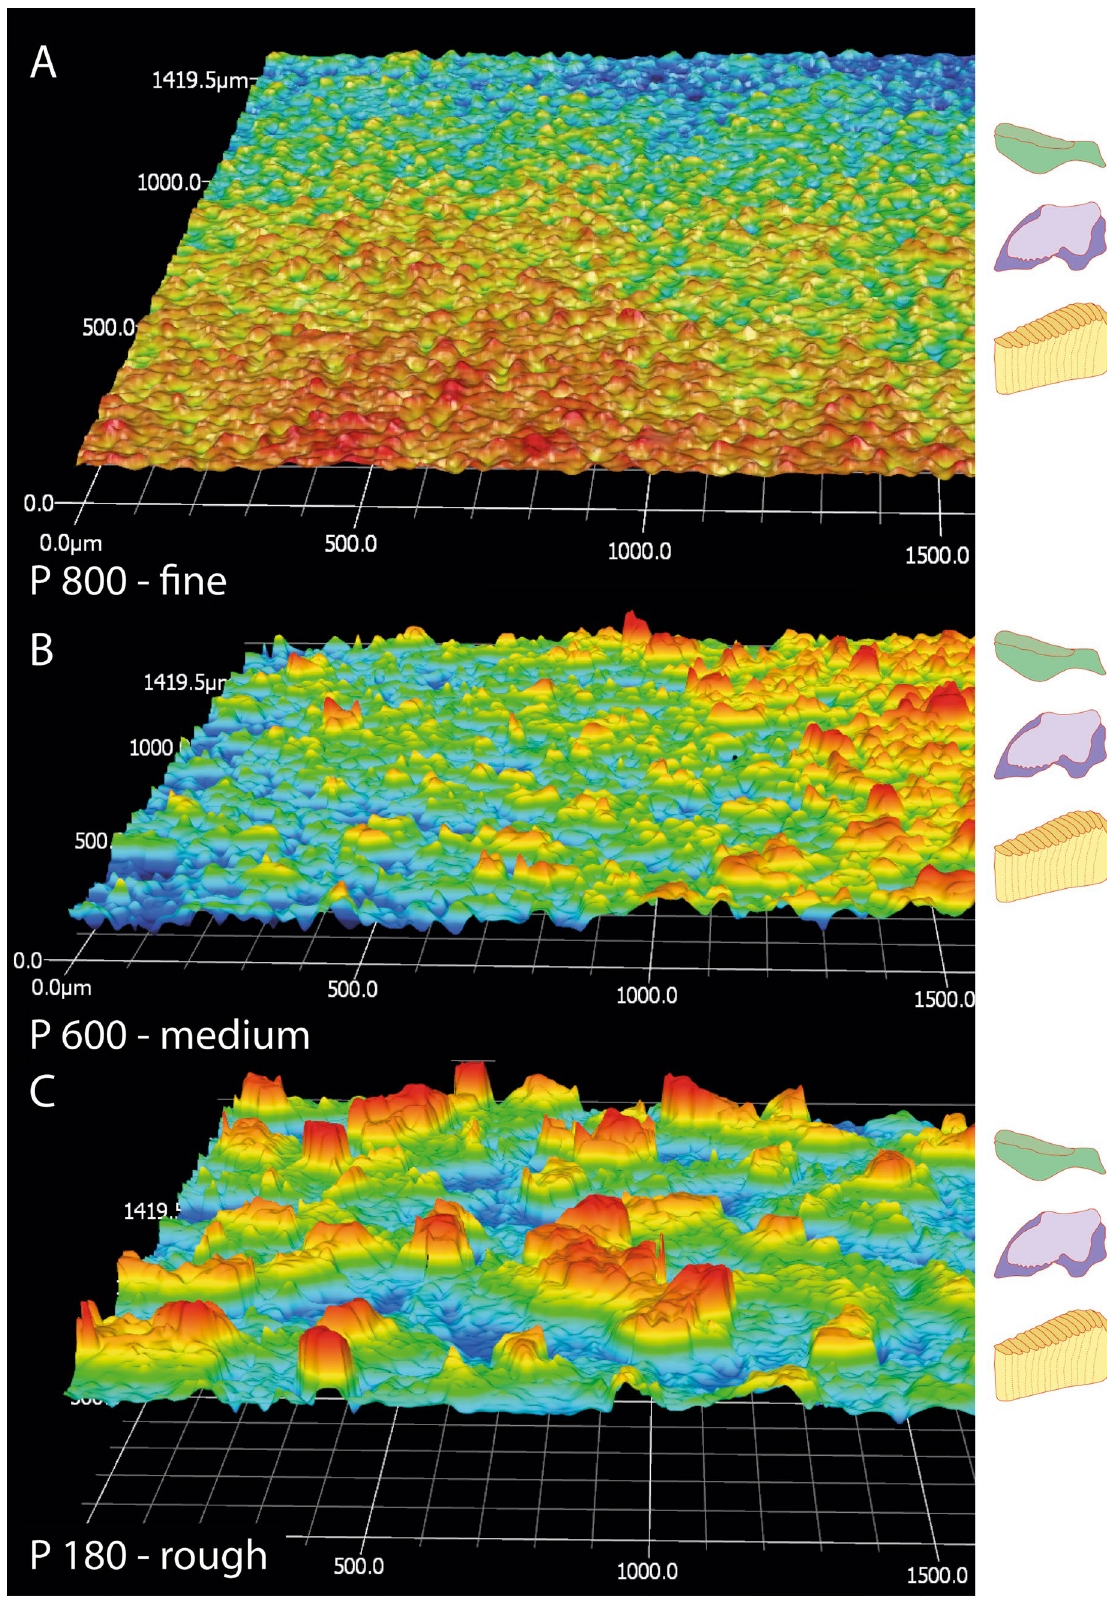
Figure 2. Relative dimensions of sandpaper profiles used in experiments and schemes of radular teeth at same scale. Left side: Surface profile of sandpapers visualized with the Keyence VR 3100. ( A ) = fine (P 800), ( B ) = medium (P 600), ( C ) = rough (P 180) sandpaper; scale bars are in µm. Right side: schematic illustration of the unworn teeth (lateral I, lateral II, inner marginals) drawn with Adobe Illustrator CS